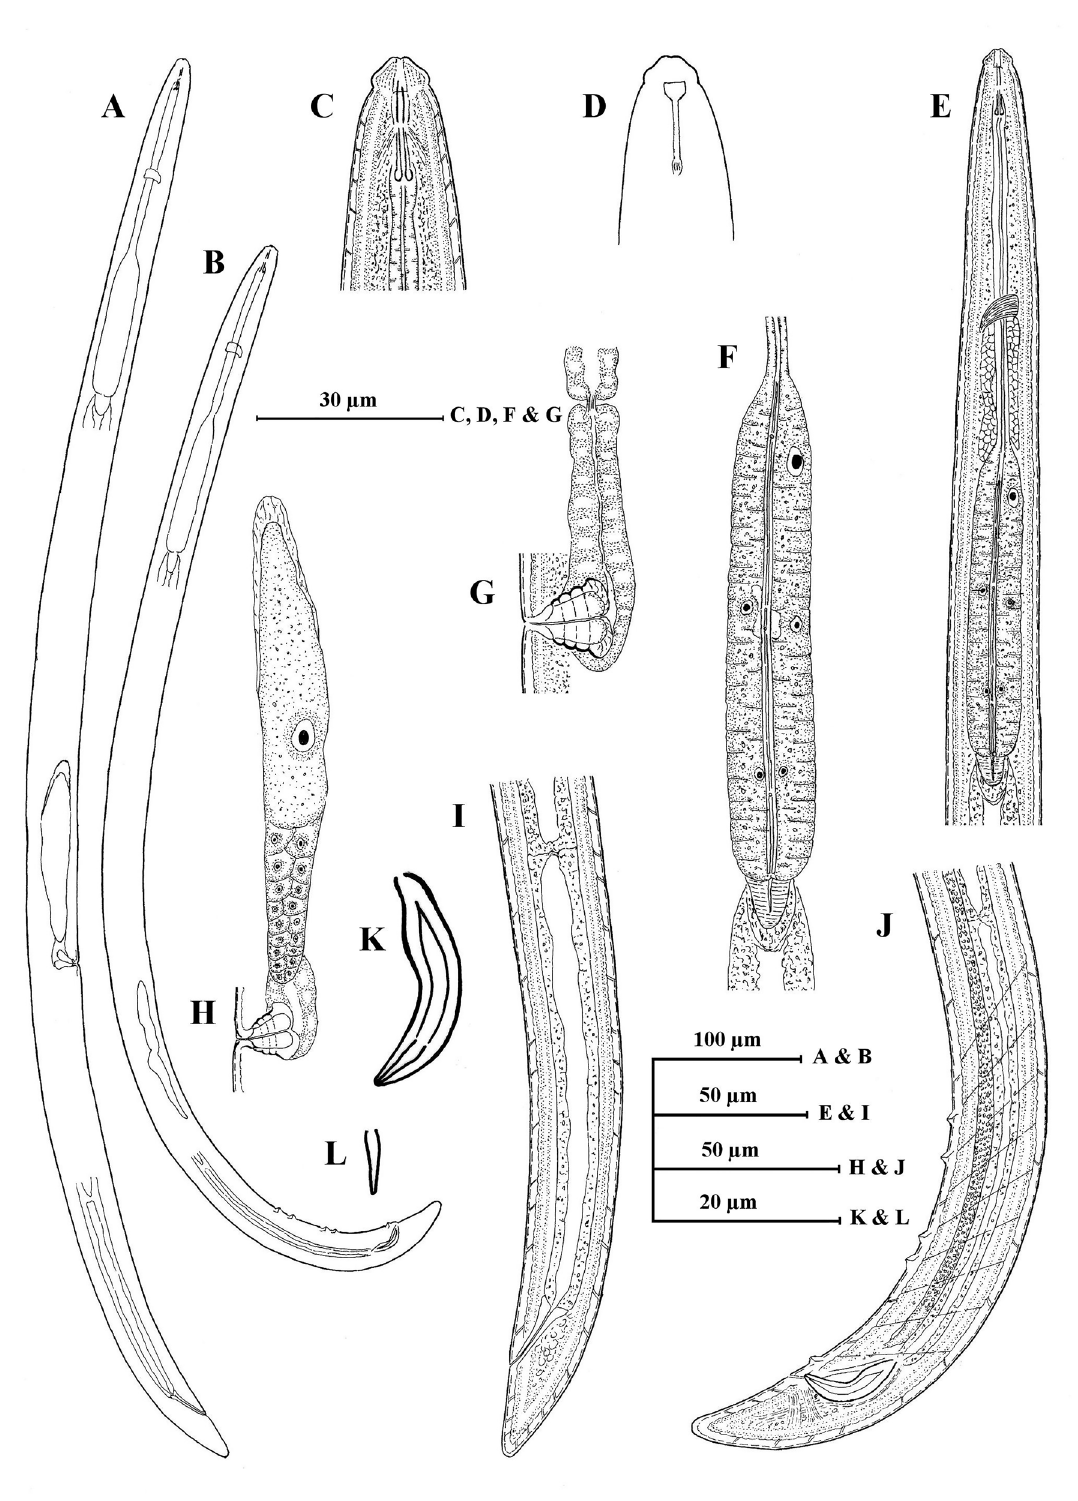
Fig. 1. Tylencholaimus mirabilis (Bütschli, 1873). A . Entire female. B . Entire male. C . Female anterior region. D . Female anterior region showing amphid. E . Female pharyngeal region. F . Female expanded part of pharynx. G–H . Female genital system. I . Female posterior region. J . Male posterior region. K . Spicule. L . Lateral guiding